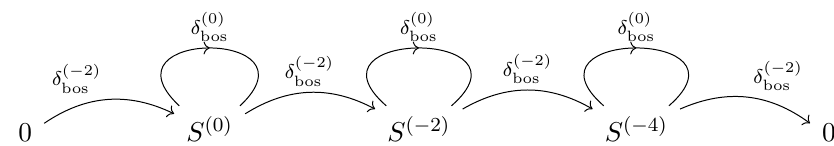
Figure 1 . Schematic representation of the symmetry transformation of the different terms in (3.1) under generic Lorentzian bosonic symmetries δ bos . We see that only the leading order is invariant under Lorentzian boosts by itself. This is equivalent to the statement of manifest Galilei invariance of S NR = lim c →∞ S